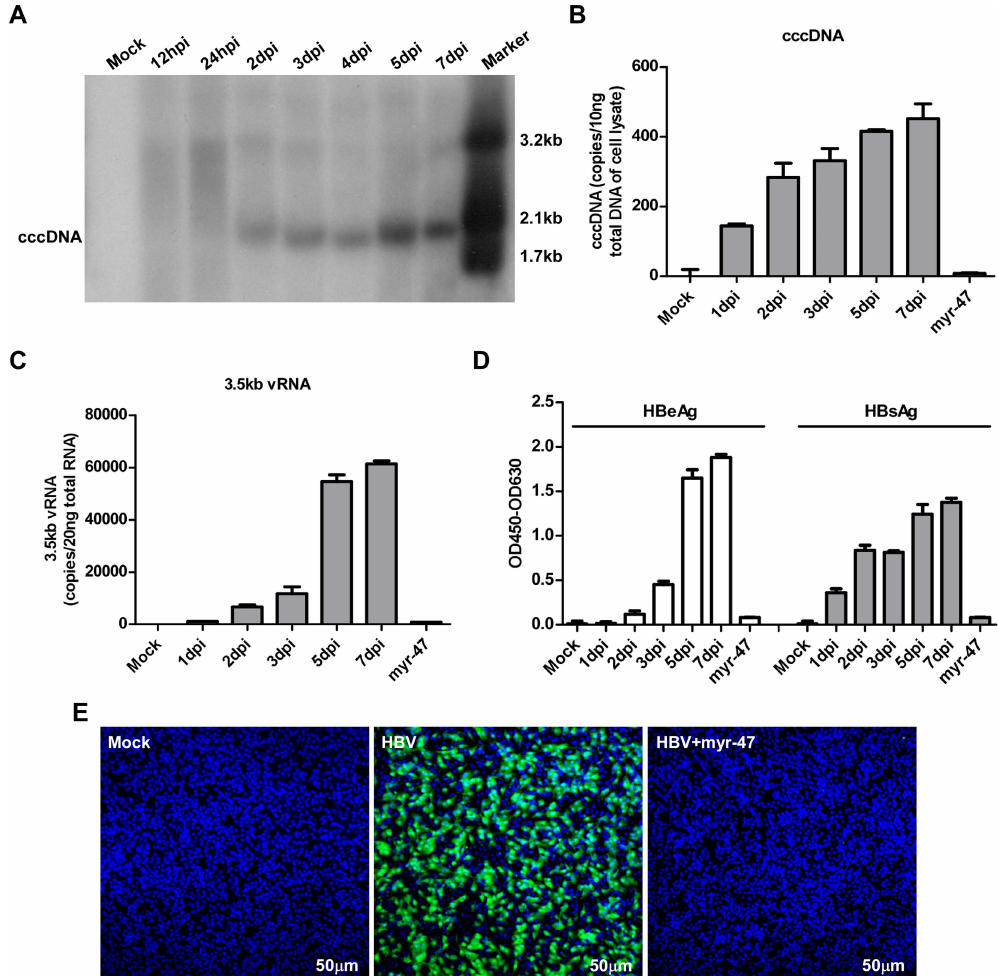
Fig 1. Kinetics of cccDNAformation in HepG2-NTCP cells infected by HBV. HepG2-NTCP cells were inoculatedfor 24 h with HBV in the presence of 4% PEG8000 with or without 100 nM preS1-myr-47 lipopeptide. The cells were then cultured for 7 days in PMM. (A) HBV cccDNA was extracted at indicatedtimes post infection using Hirt method and followedby digestionwith Hind III. The DNA samples were analyzedby Southern blot with an [ α - 32 P]dCTP-labeled full-lengthHBV DNA probe. 100 pg each of 3.2kb, 2.1kb and 1.7kb HBV DNA fragments were used as molecular weight markers; dpi: days post infection; cccDNA: covalently closed circular DNA. (B-D) Total cellular DNA and RNA were extracted from HBV infected HepG2-NTCP cells. HBV cccDNA (B) and 3.5kb vRNA (C) levels at the indicatedtimes post-infection were quantified by real-time qPCR assays. Secreted HBeAg and HBsAg were measured by ELISA (D). Representatives of three independent experiments are presented. (E) On 7 dpi, the cells were fixed and stained for intracellular HBcAg with mcAb 1C10 (green) and nuclei were stained with DAPI (blue). Images were captured with a Nikon A1-R confocal microscopy. Scale bars, 50 μ